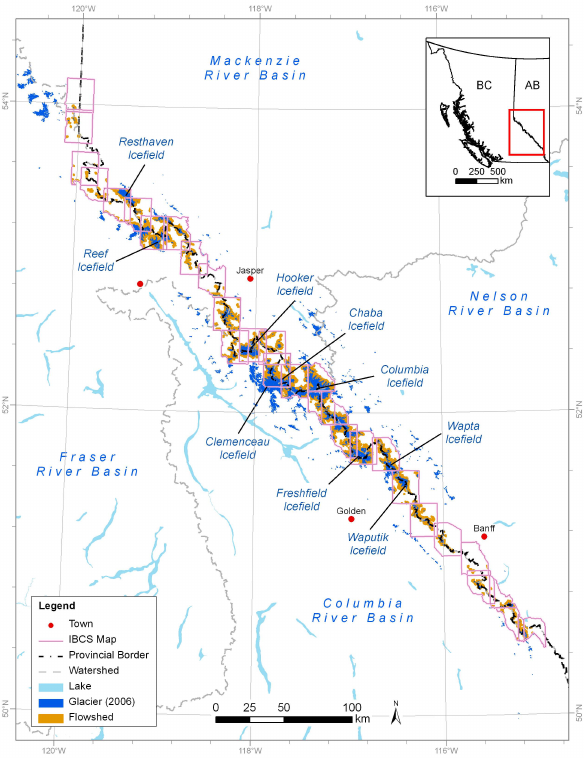
Fig. 1. Glaciers in the central and southern Canadian Rocky Moun- tains. Glaciers encompassed by the orange flowsheds are the fo- cus of this study and include glaciers mapped by the Interprovincial Boundary Commission Survey between 1903 and